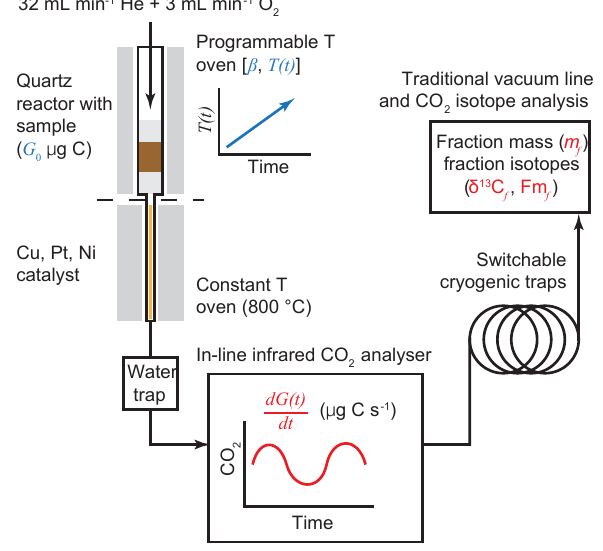
Figure 1. RPO instrument schematic. User-defined inputs are printed in blue, while observed measurements are printed in red (see Table 1 for symbol